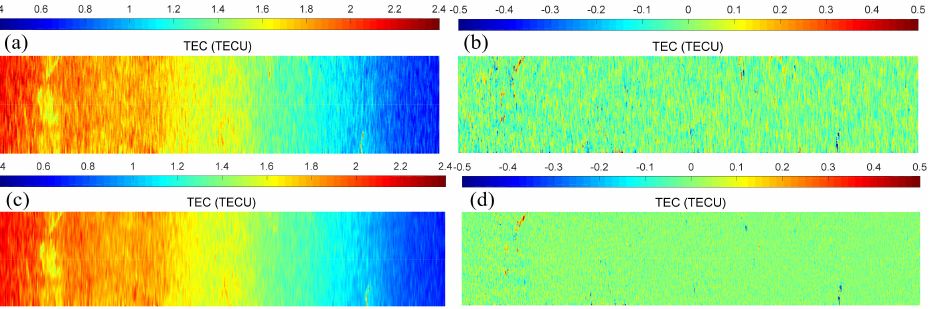
Figure 6. TEC retrieval in Ottawa based on L-band SAR ( a ) and P-band SAR ( c ) with low systematic error level. The deviations between the retrieval and the true values (Figure 1b) are shown in ( b , d ).